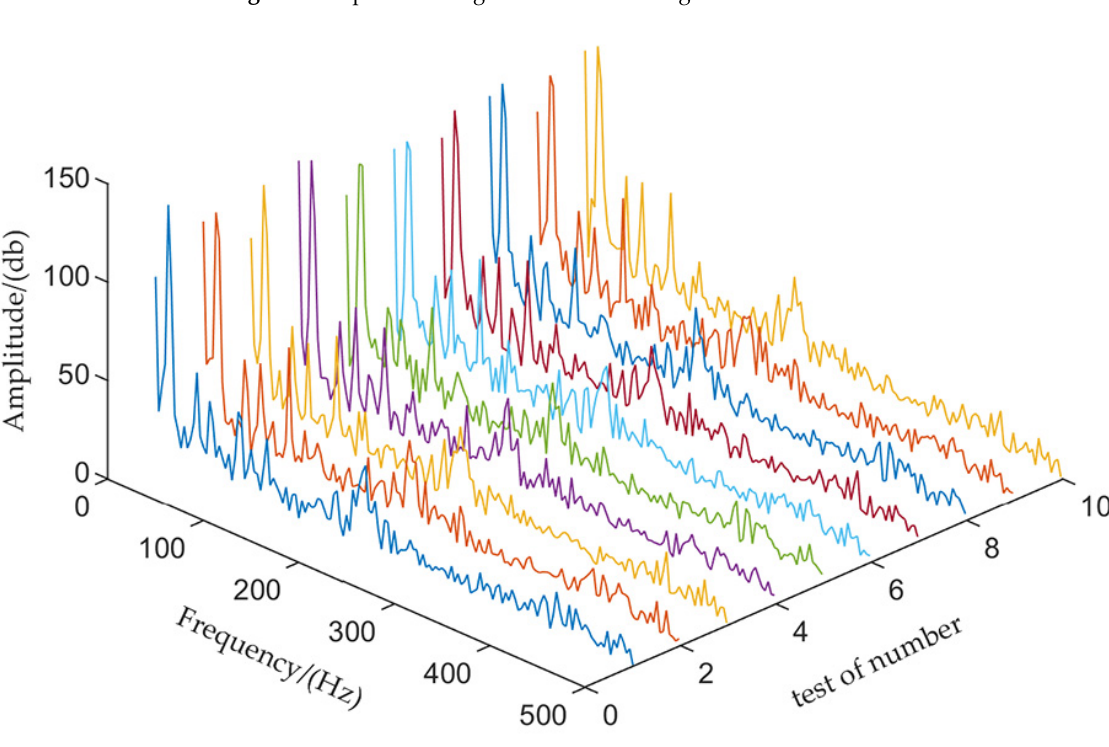
Figure A2. Spectrum diagram of loaded signal.